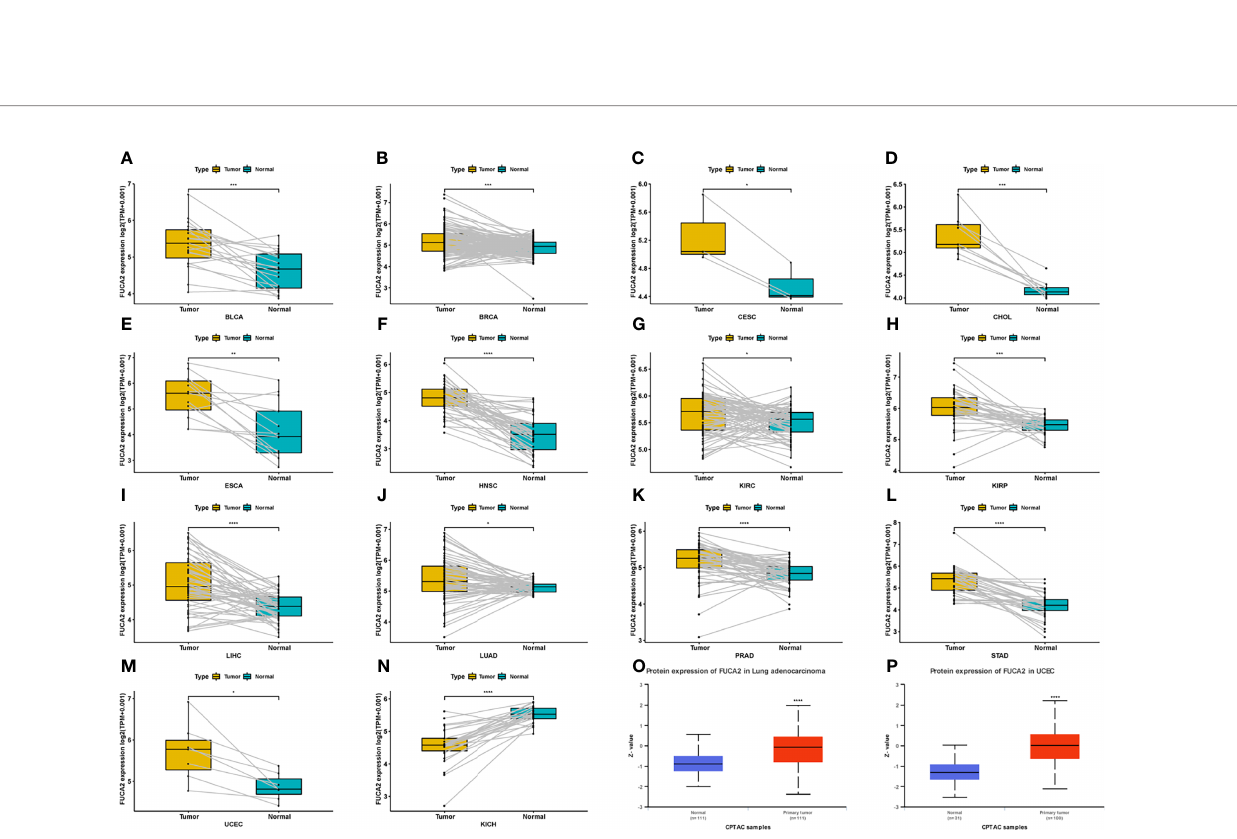
FIGURE 2 | Patterns of FUCA2 levels between tumor and normal tissues. (A – N) levels of FUCA2 in paired tumor and normal tissues across different cancers based on a TCGA dataset. (O, P) Protein expression level of FUCA2 in LUAD and UCEC. *P < 0.05, **P < 0.01, ***P < 0.001, ****P < 0.0001.